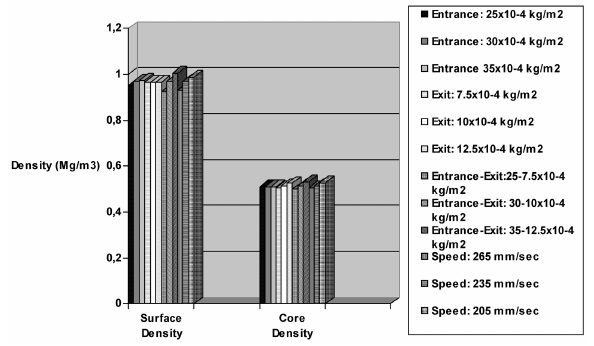
Figure 1. Effects of entrance and exit pressures, and feed- ing speed on the surface and core